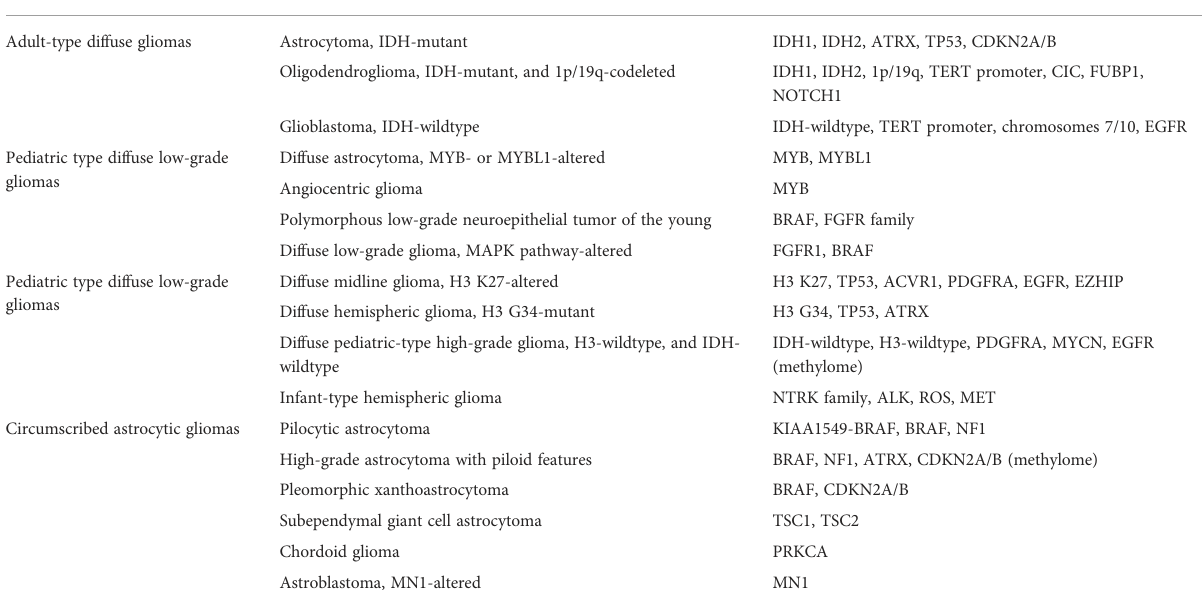
TABLE 1 Families and types of gliomas with relevant genetic parameters